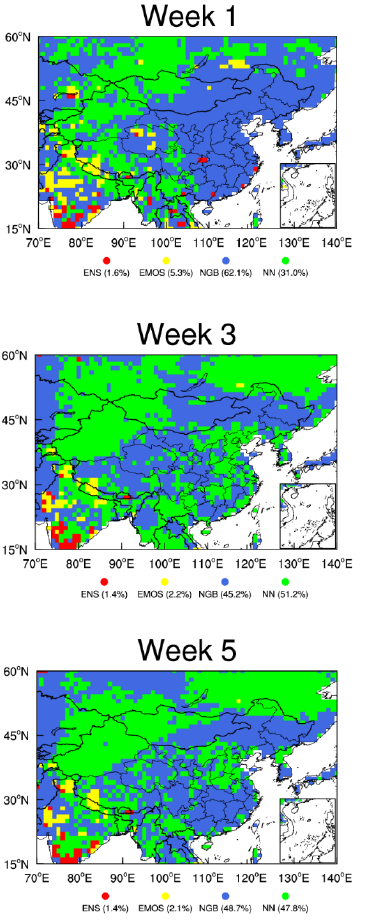
Figure 8. Percentage of the best-performing post-processing methods over the land surface in terms of the mean continuous ranked probability score over validation period at different lead times. The percentage of the best-performing forecast of each method is listed under the mosaic image. ENS, raw ensemble; EMOS, ensemble model output statistics; NGB, natural gradient boosting; NN, neural network.